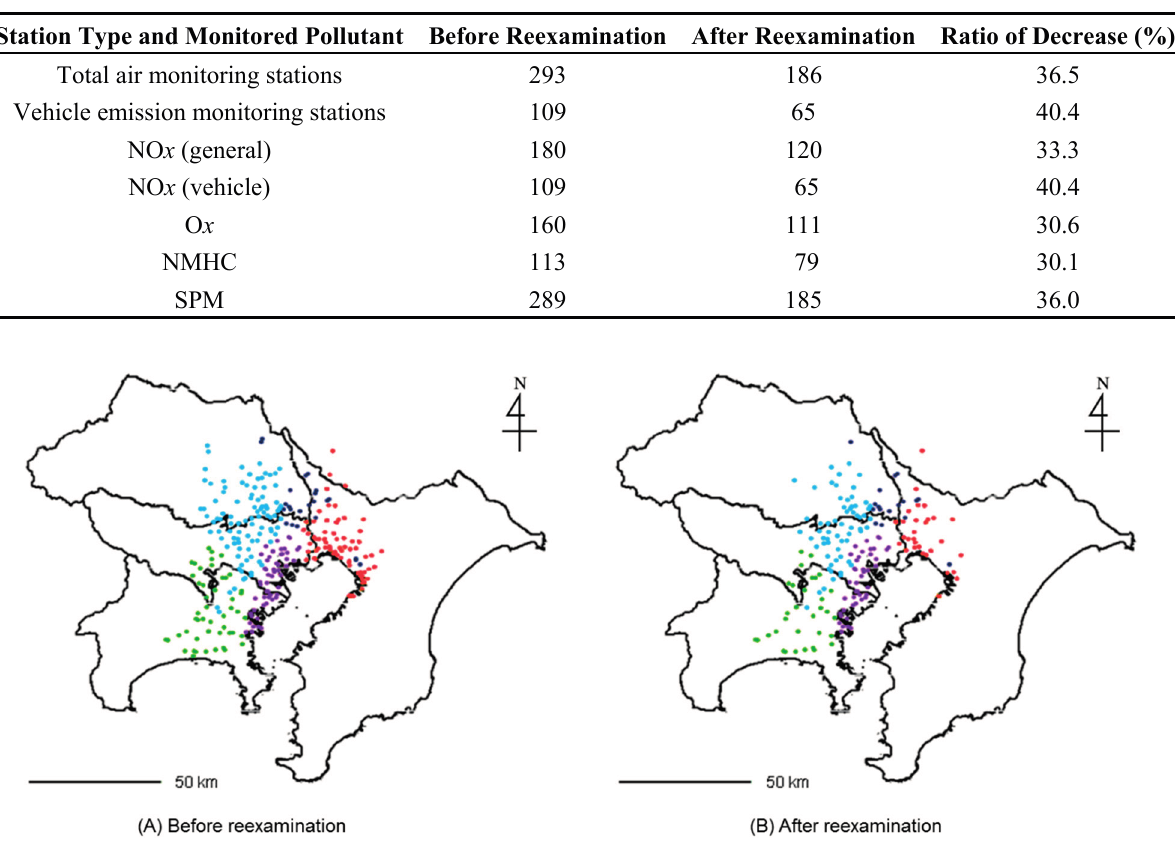
Table 3. Number of air monitoring stations in semi-urban and urban areas before and after reexamination (retention ratios for criteria were all 10%).